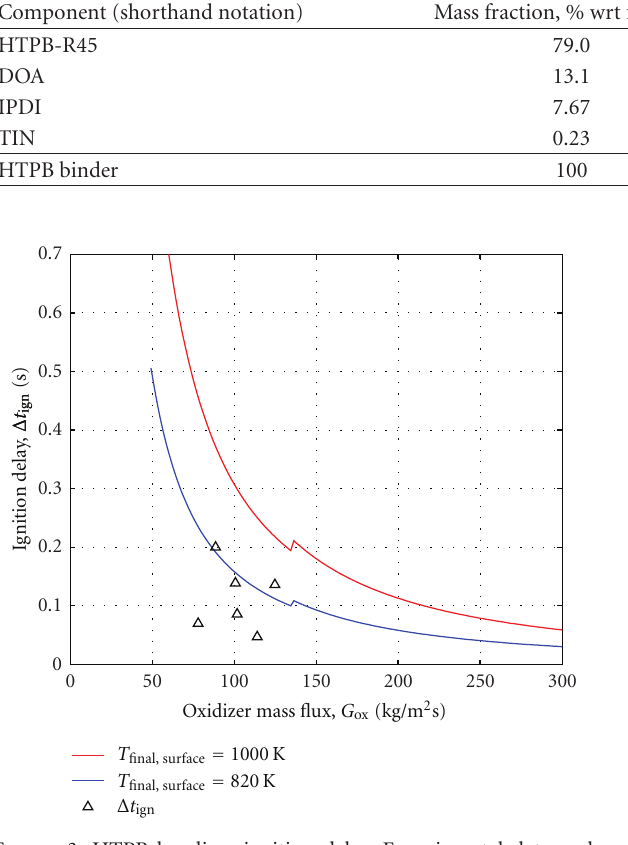
Figure 4: HTPB baseline: diameter change in time for all performed tests.